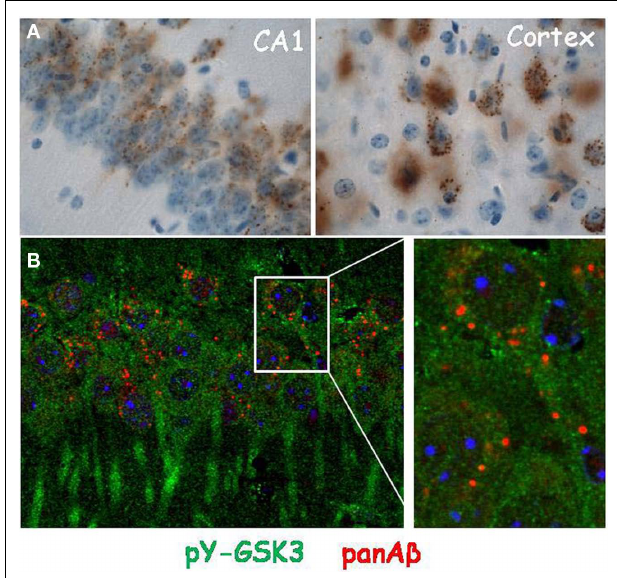
FIGURE 2 | Localization of amyloid peptides and pY-GSK3 in transgenic mouse brain. (A) Intracellular amyloid (panA β ) in granules in pyramidal neurons of CA1 (left) and cortical layers III/IV (right) in brain of APP.V717I mice (age 6months); (B) localization of activated pY-GSK3 (green) and panA β (red) in the cytoplasm of CA1 neurons in the brain of APP.V717I mice (age 6months), at right higher magnification of boxed